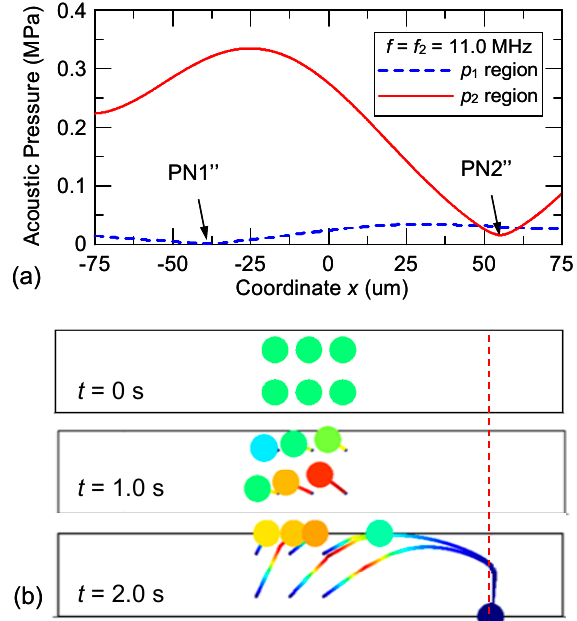
Figure 7. ( a ) Calculated acoustic pressure variations and ( b ) particle trajectories in the design of the series IDTs using the input frequency f 2 = 11.0 MHz in the p 1 and p 2 regions.